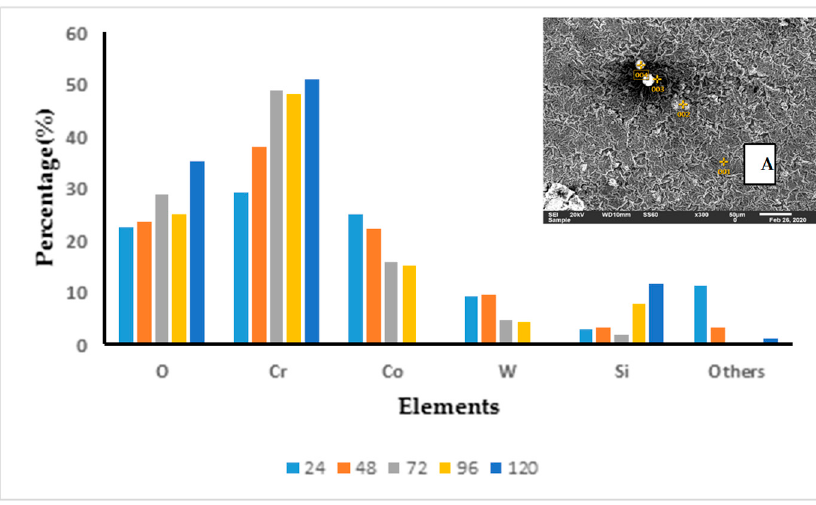
Figure 11. Elemental EDS analysis of the surfaces of the T-800/WC coating for up to 120 h.